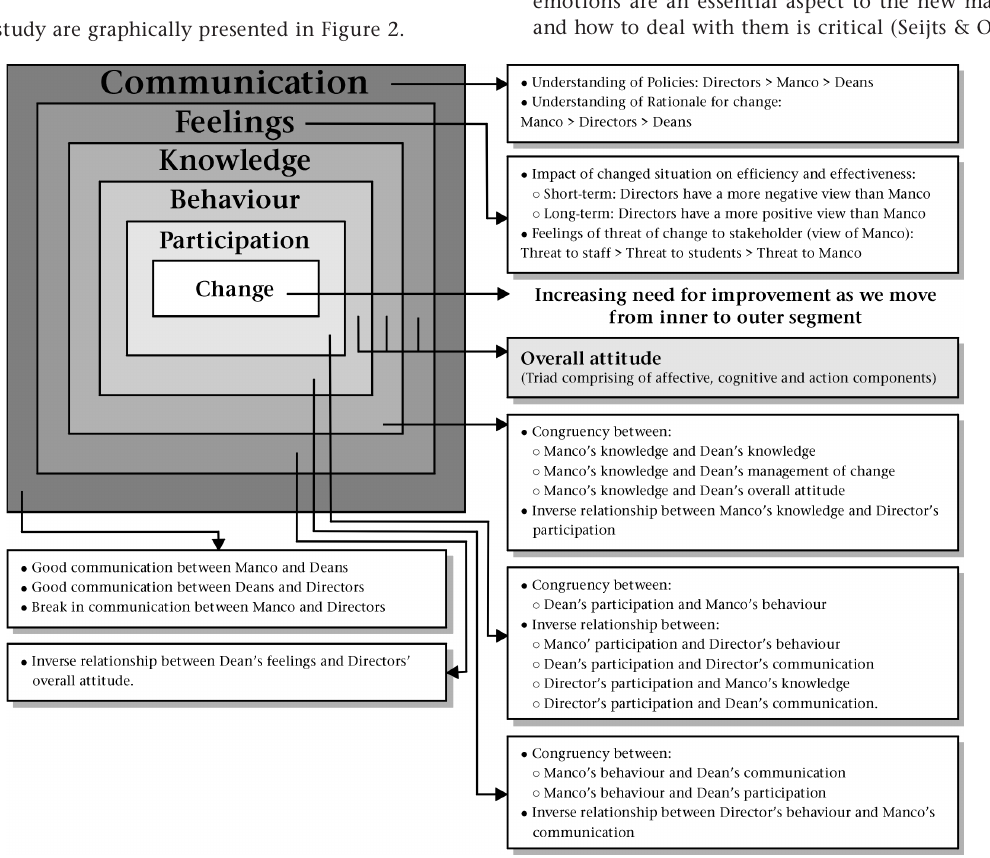
Figure 2: Results of the